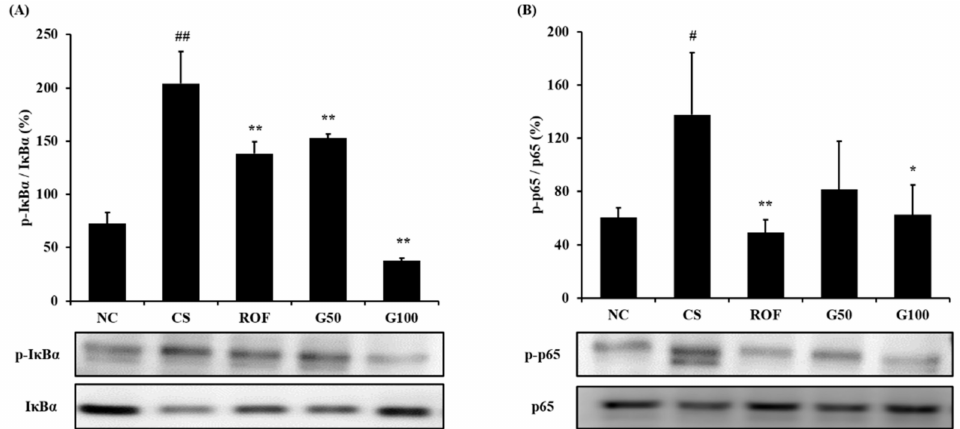
Figure 7. GGWE decreased the phosphorylation of I κ B α and NF- κ B expression in lung tissue. ( A ) phosphorylation of I κ B α expression and quantitative analysis for phosphorylation of I κ B α expression, ( B ) phosphorylation of NF- κ B expression and quantitative analysis for the phosphorylation of NF- κ B expression. NC, non-treated mice; CS, CS and LPS exposure mice; ROF, roflumilast 10 mg/kg and CS and LPS exposure mice; G50, GGWE 50 mg/kg and CS and LPS exposure mice; G100, GGWE 100 mg/kg and CS and LPS exposure mice. The values shown are the mean ± SD. ## p < 0.01 vs. NC; # p < 0.05 vs. NC; ** p < 0.01 vs. CS; * p < 0.05 vs.